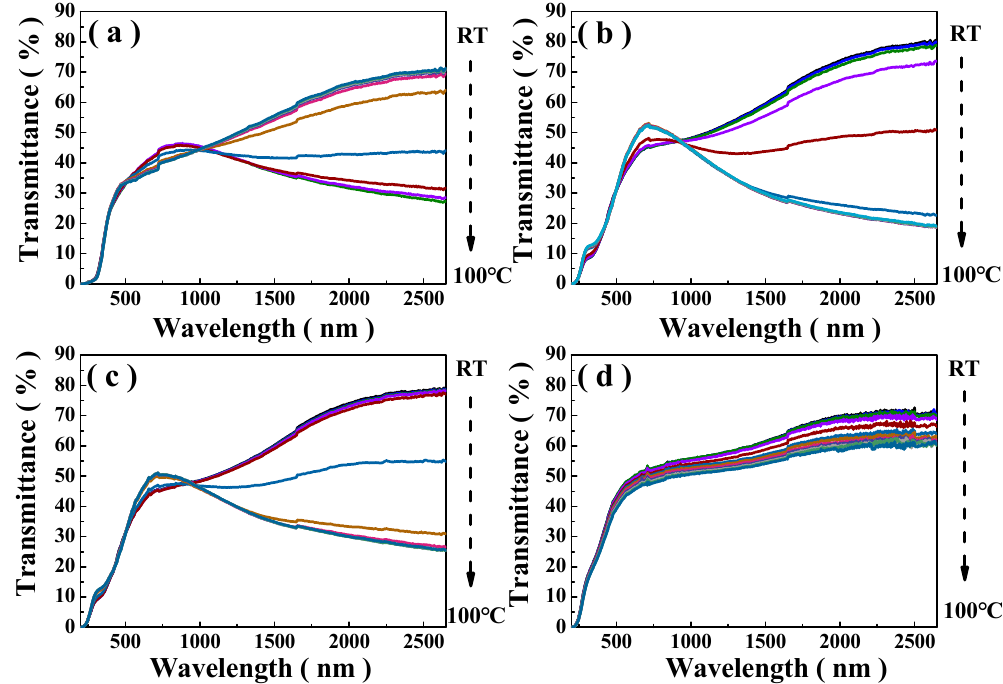
Figure 5. Optical transmittance curves of the VO 2 /Cu 50 Zr 50 /glass thin films in the range of 200–2650 nm by varying temperature, for various thicknesses of Cu 50 Zr 50 buffer layer. ( a ) No layer; ( b ) 40 nm thickness; ( c ) 80 nm thickness; and ( d ) 160 nm thickness.